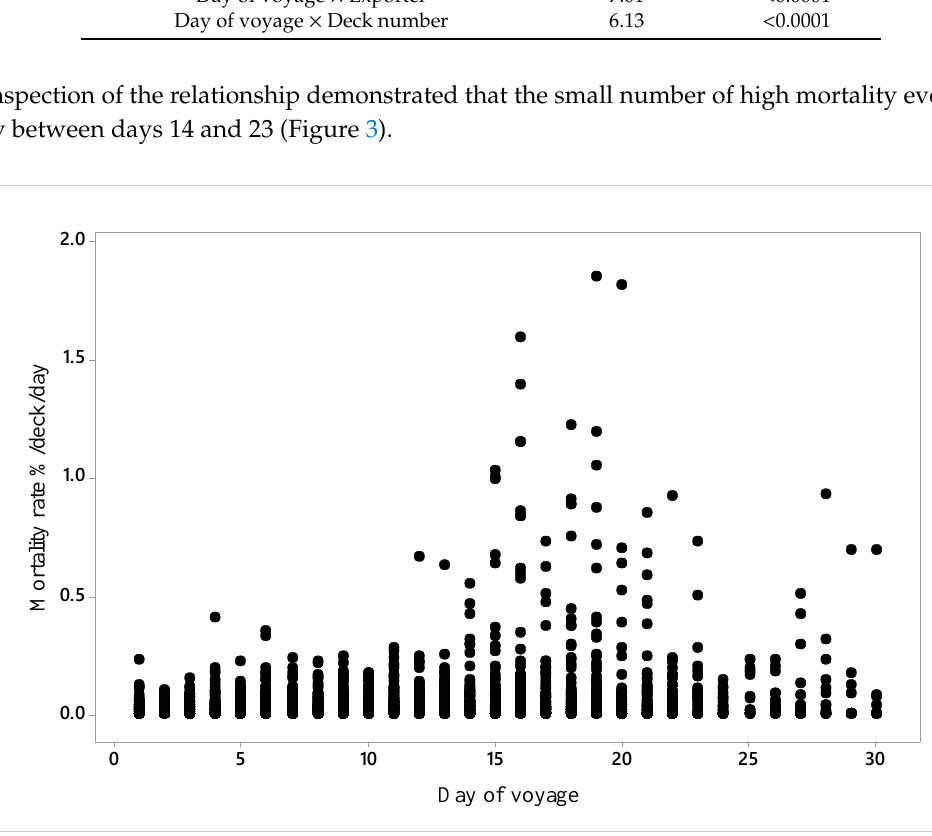
Figure 3. Mortality rate (%/deck/day) during the days of all 14 voyages ( n = 3026).